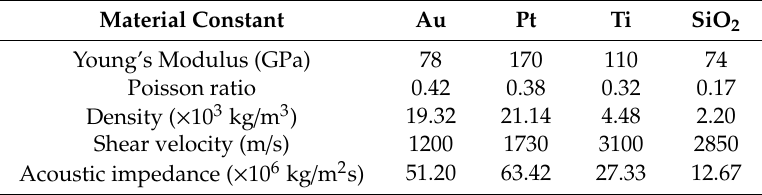
Table 1. Part of material constants of gold, platinum, titanium, and silicon dioxide [39]. Material Constant